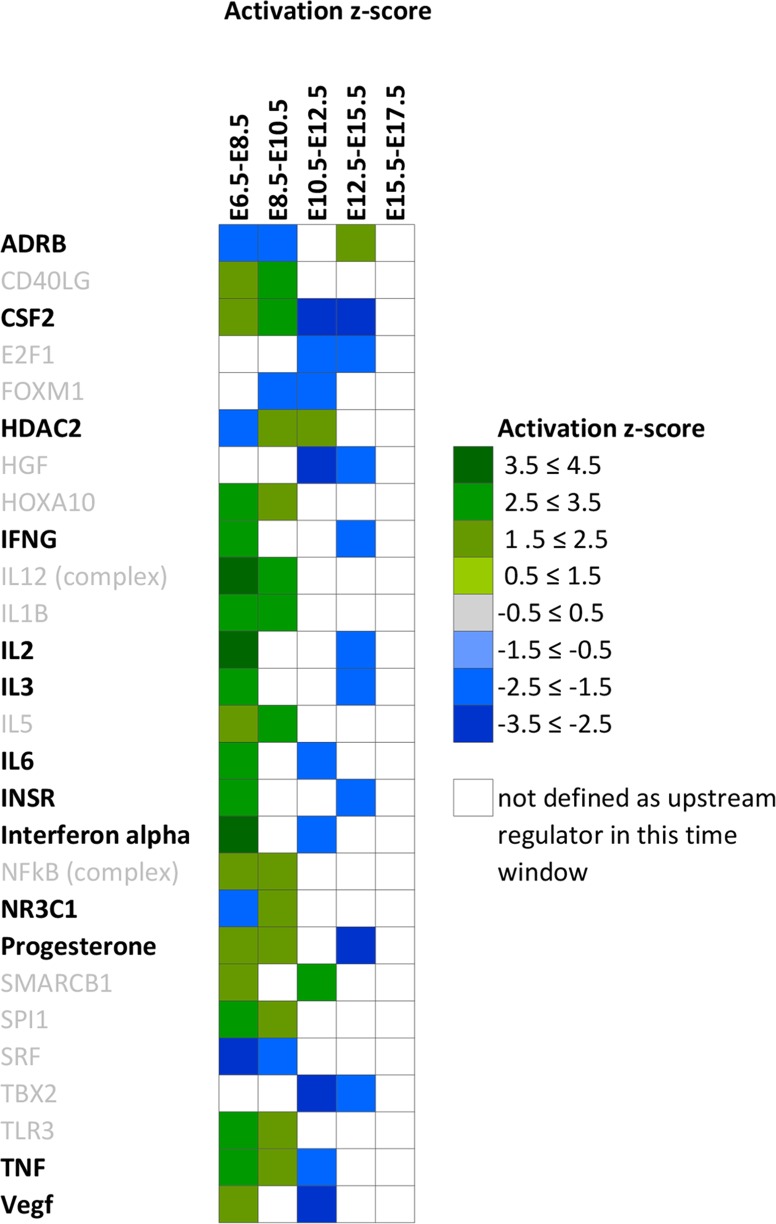
Predicted repetitive upstream activators.Depicted are upstream activators with an activation or inhibition Z score of respectively > 2.0 or < (-2.0) present in at least 2 time window comparisons. Positive Z-scores are depicted in green, negative Z-scores are depicted in blue.